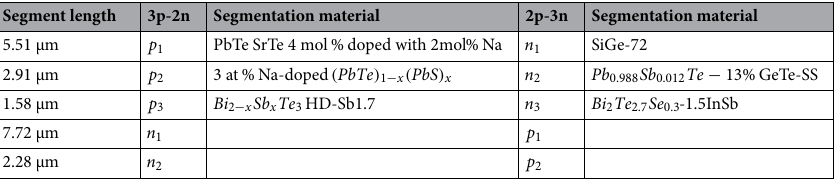
Table 1. Dimensions of the segmented thermoelectric micro generator TEG.